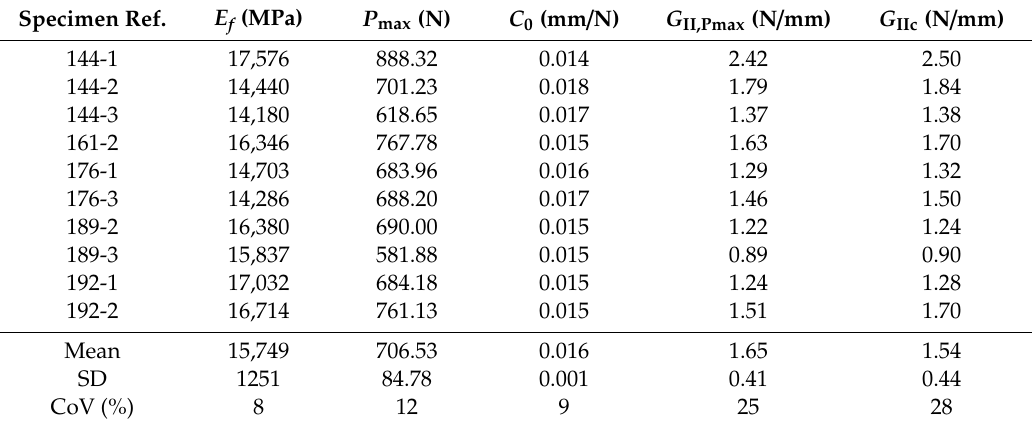
Table 3. Flexural modulus ( E f ), maximum load ( P max ), initial compliance ( C 0 ), strain energy release rate at maximum load ( G II,Pmax ) and critical strain energy release rate ( G IIc ) in Mode II by CBBM. Specimen